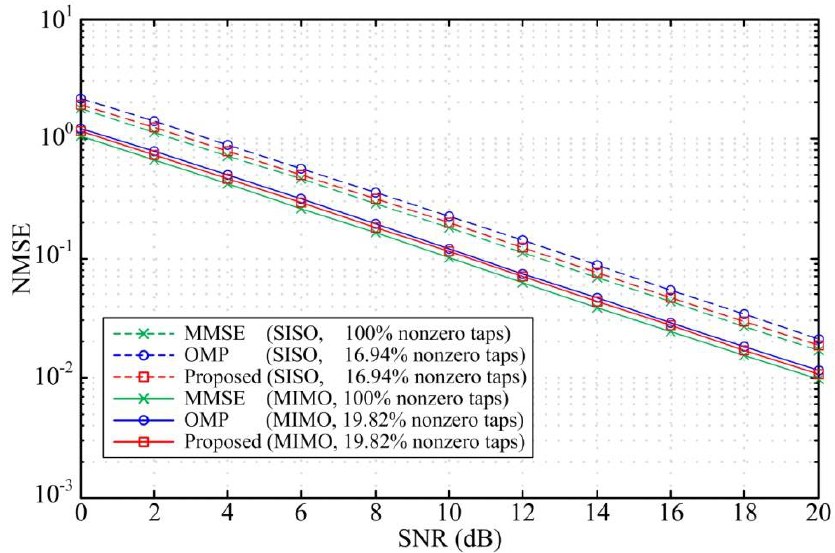
Figure 4. NMSE versus SNR for SISO DFE and MIMO DFE in the Vehicular A channel with η max = 0.6 dB and N f = 50.